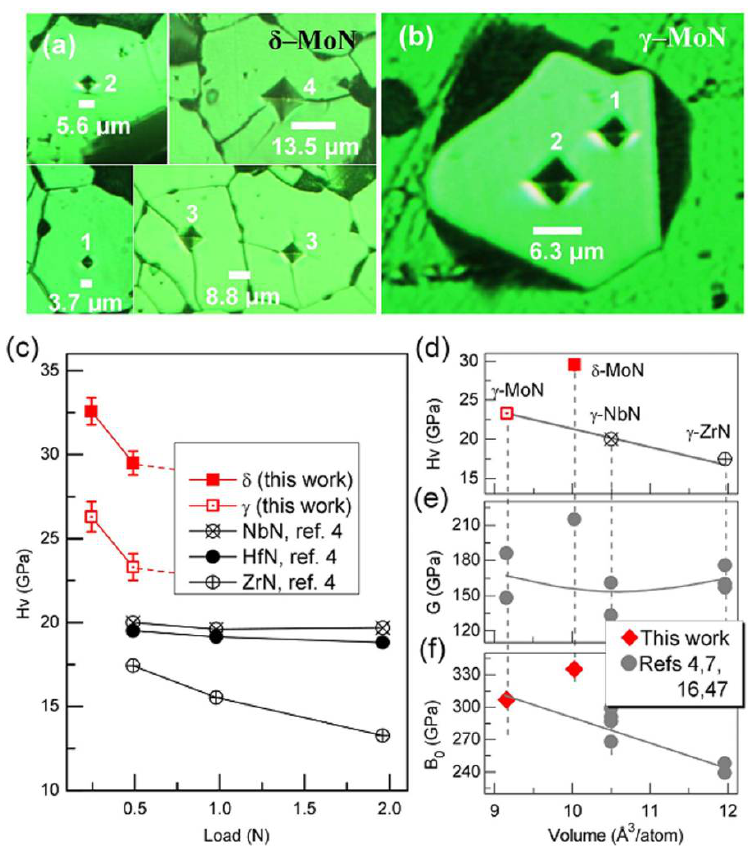
Figure 12. ( a , b ) Vickers hardness measurement for single-crystal δ – and γ –MoN. Indentations numbered with (cid:48) 1 (cid:48) , (cid:48) 2 (cid:48) , (cid:48) 3 (cid:48) , and (cid:48) 4 (cid:48) correspond to applied loads of 0.245, 0.49, 0.98, and 1.96 N, respectively. The crystals in ( a ) were prepared by sintering of phase-pure δ –MoN powders at 8GPa and 1800 ◦ C for 60 min. The γ –MoN crystal in ( b ) was directly grown using an ion–exchange reaction (see Figure 1e). ( c ) Vickers hardness, H V , of δ – and γ –MoN as a function of applied load. Also plotted are the reported H V values for other hard nitrides including ZrN, NbN, and HfN (ref. [4]). ( d ) H V vs. volume per atom (i.e., normalized volume in terms of per atom) for γ –MoN, γ –ZrN (ref. [4]), and γ –NbN (ref. [4]) under a load of 0.49N. ( e ) Bulk modulus, B 0 , vs volume per atom. The measured bulk moduli for δ – and γ –MoN are ~335 and ~307GPa, respectively, based on compression experiments (Suppl Figures S6 and S7). ( f ) Shear modulus, G, vs. volume per atom. Reprinted with permission from Wang et al., “The hardest superconducting metal nitride.” Sci. Rep. 5, 13733